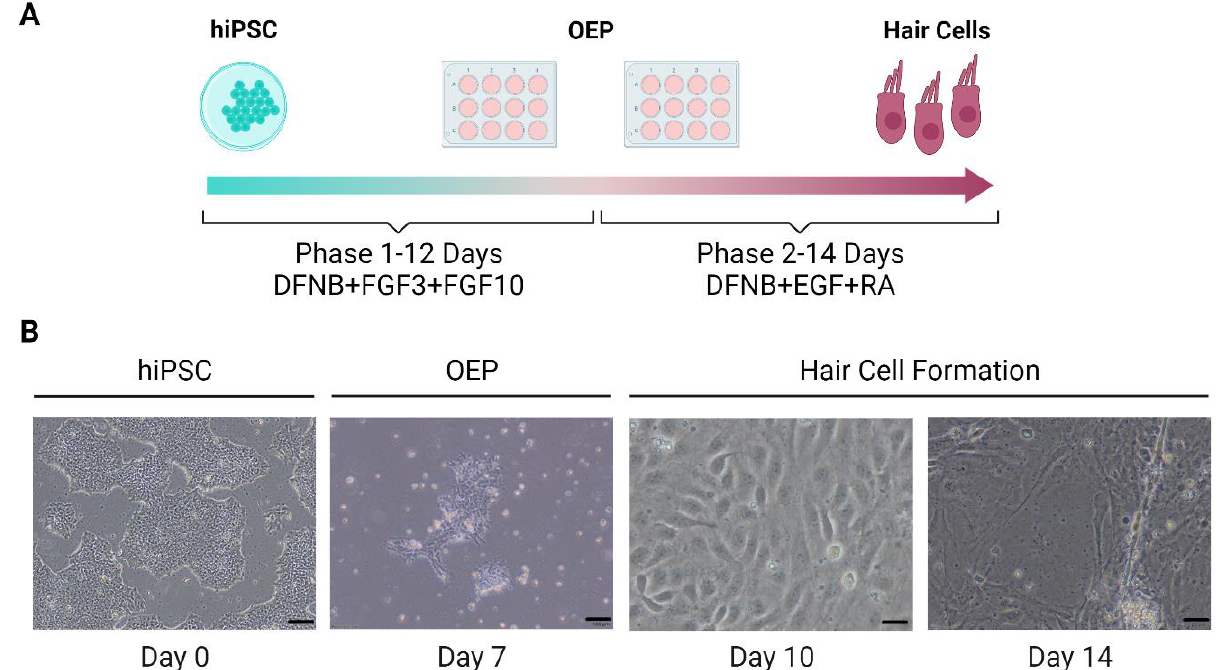
Figure 3. Schematic representation of 2D differentiation protocol of hPSCs-derived hair cells. ( A ). Protocol of the generation of inner ear hair cells from hPSCs. ( B ). Images obtained by microscopy of hair cell formation. Scale bar at day 0 and 7 =100 µ m and at day 10 and 14 =20 µ m. OEP: Otic epithelial progenitor. (Created with BioRender.com, accessed on 4 December 2022).